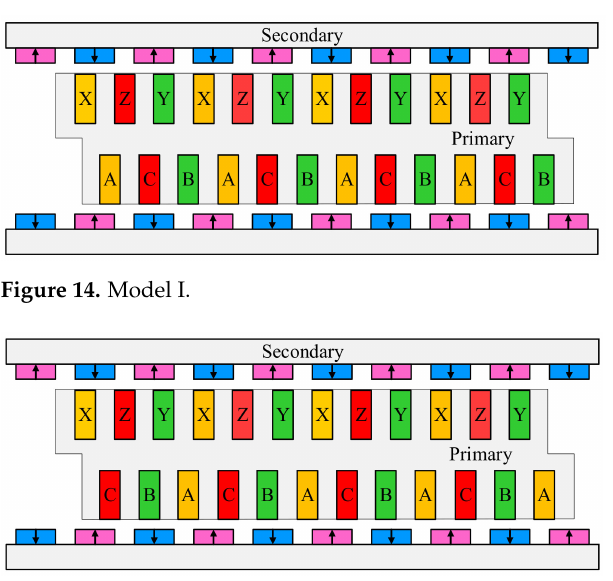
Figure 15. Model